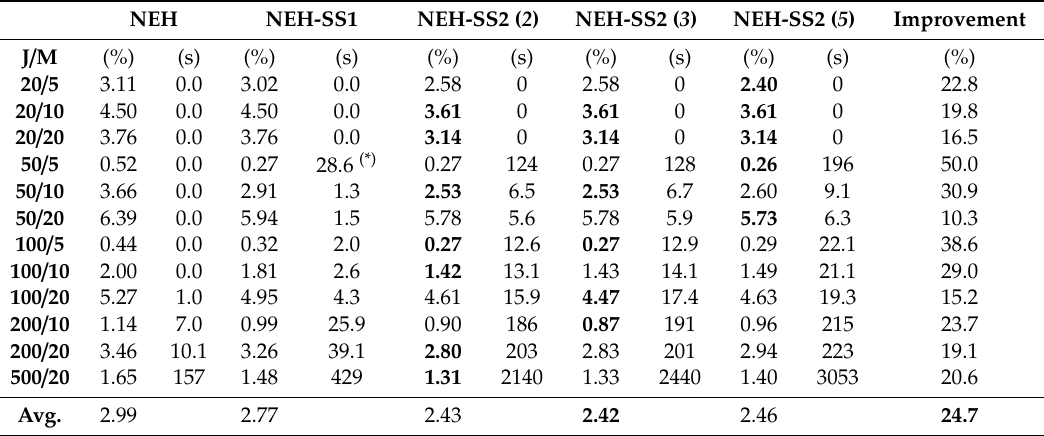
Table 4. NEH-SS2 improvement heuristic results (ARPD in % and average CPU times in